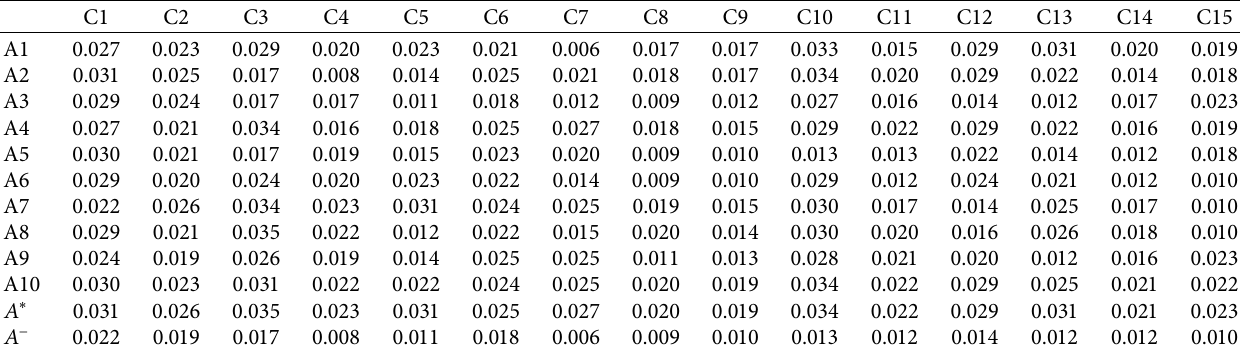
Table 11: Weighted normalized decision matrix E, A ∗ and A − for HF-AHP-TOPSIS.